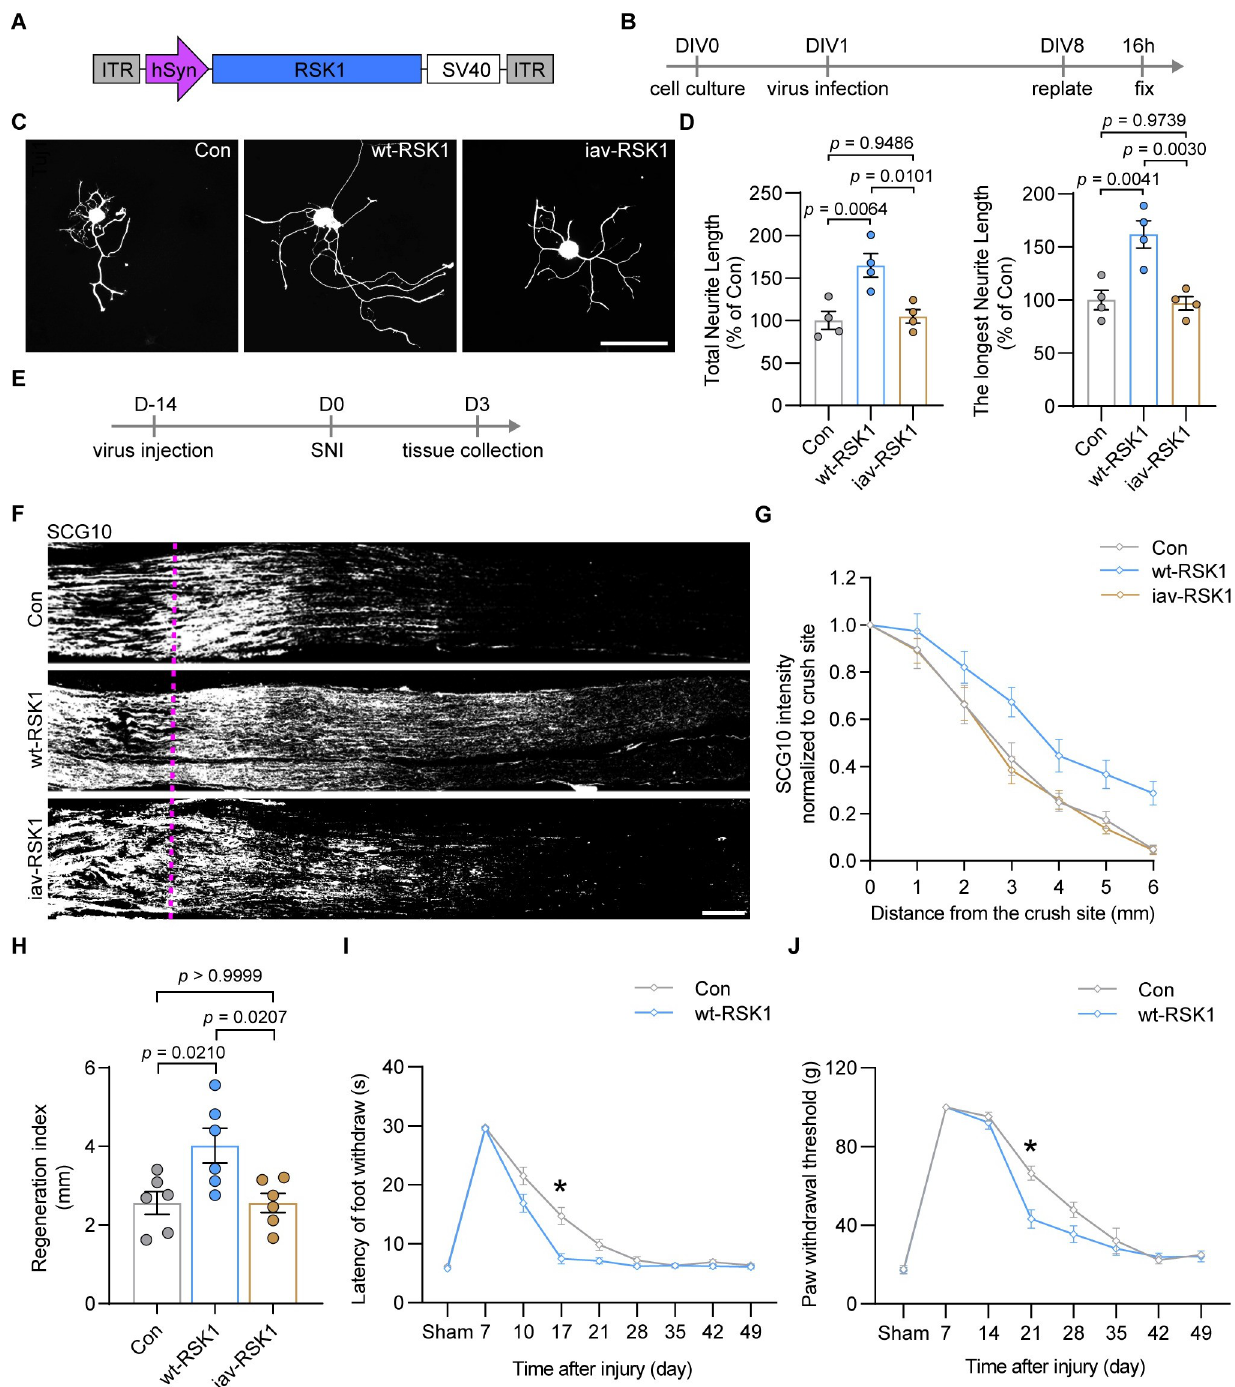
Fig 4. RSK1 promotes DRG neuron axon regeneration and functional recovery after injury. (A) A schematic representation of the AAV2/8-hSyn- RSK1 vector utilized in RSK1 OE experiments. (B) Timeline for RSK1 OE in DRG neurons at DIV1. (C) Representative images of cultured DRG neurons infected with control AAV2/8 (Con), AAV expressing wt-RSK1, or AAV expressing inactive mutant (S221A, S380A, and T573A) RSK1 (iav-RSK1). Scale bar, 100 μ m. (D) Quantification of the total and the longest neurite outgrowth per neuron relating to (C) (mean ± SEM, 1-way ANOVA, Tukey post hoc test, n = 4 biologically independent experiments, approximately 50 cells/experiment on average). (E) Timeline for RSK1 OE in vivo and SNI. (F) Representative longitudinal sections from injured sciatic nerves. The crush site is indicated by a purple dotted line. Scale bar, 500 μ m. (G) Normalized SCG10 intensity plotted in function of the distance from the crush line ( n = 6 rats per group). (H) Axon regeneration in injured rats was quantified by regeneration indices obtained from SCG10 immunostaining on day 3 after injury (mean ± SEM, 1-way ANOVA, Tukey post hoc test, n = 6 rats per